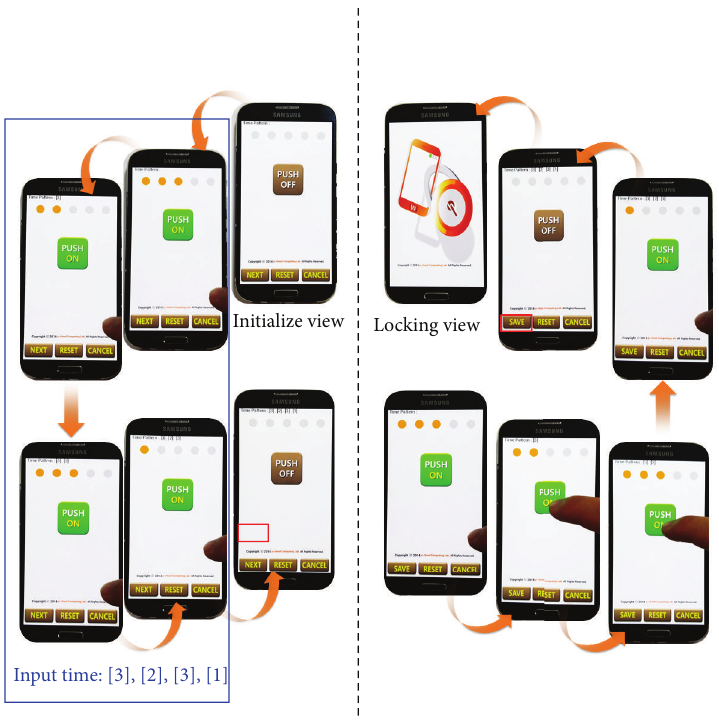
Figure 5: Setup process locking mechanism of SLSTP.